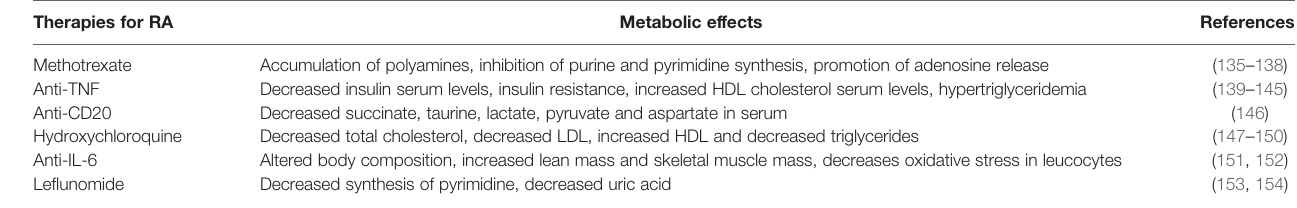
TABLE 1 | Metabolic effects of currently used therapies in rheumatoid arthritis. Therapies for